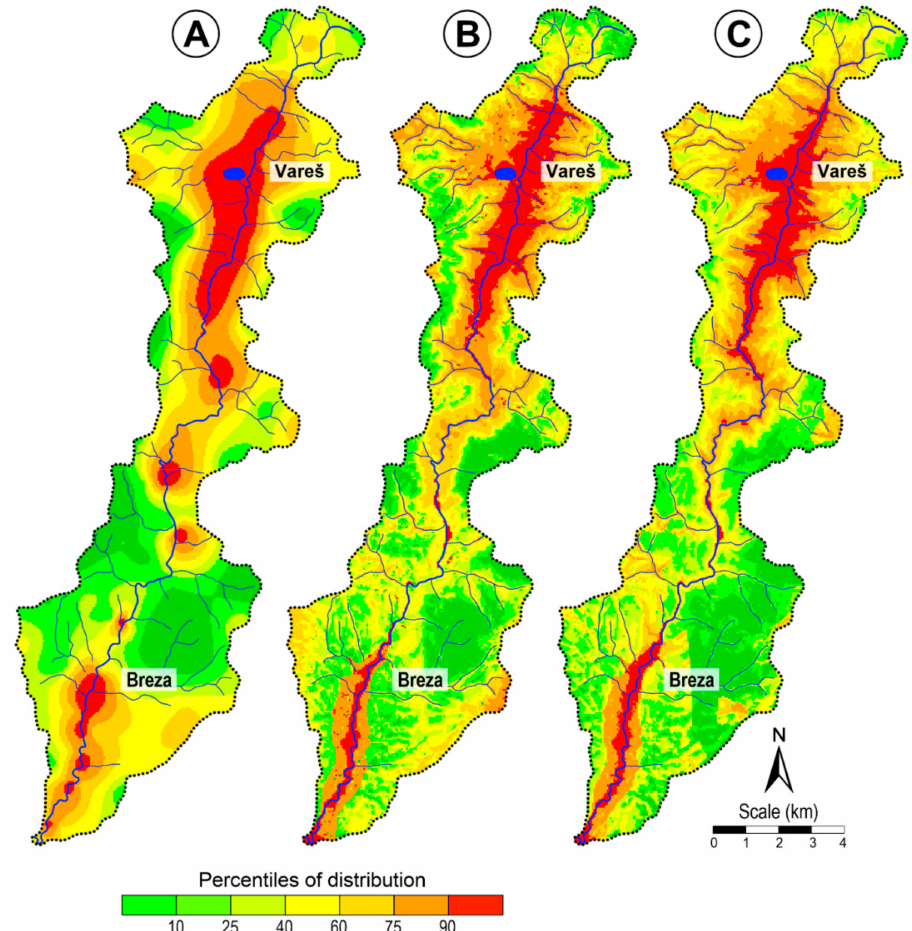
Figure 5. Spatial distribution of Lead using di ff erent predicting methods: ( A )—Kriging; ( B )—Multiple polynomial regression (MPR); ( C )—Artificial neural network—Multilayer perceptron